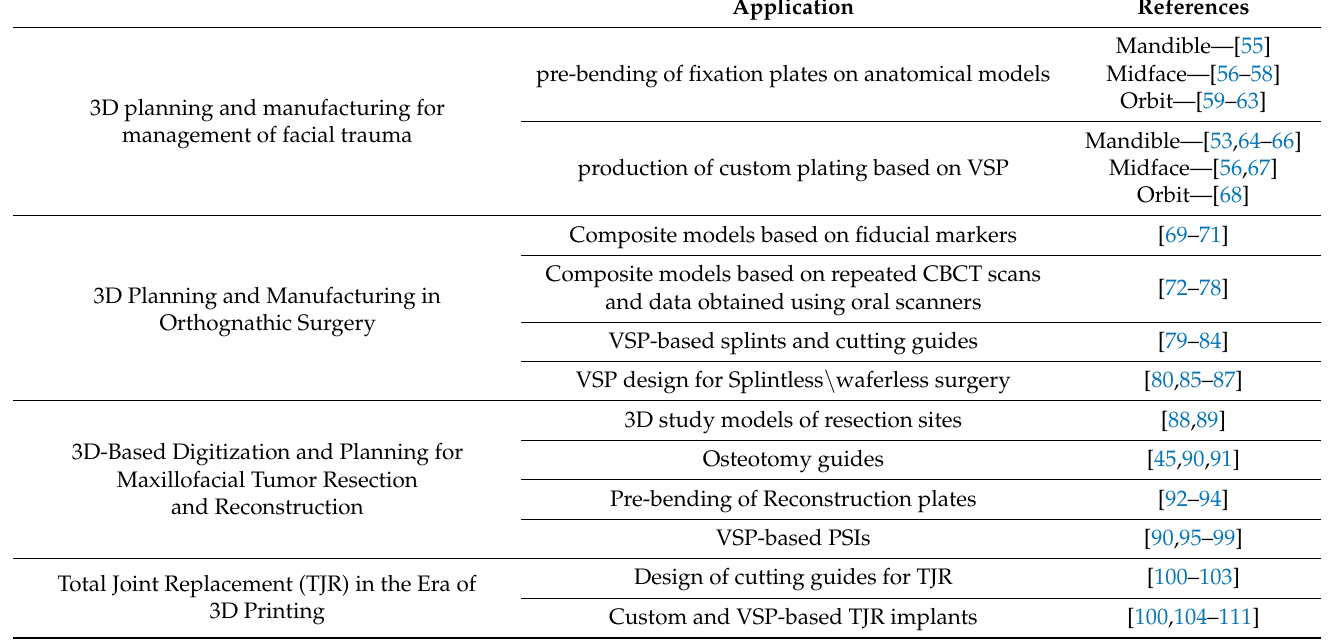
Table 1. Summary of major 3D applications in oral and maxillofacial surgery. Major fields in OMFS impacted by 3D printing technologies. VSP—virtual surgical planning. CBCT—cone beam computed tomography. PSI—patient specific implants. TJR—total joint